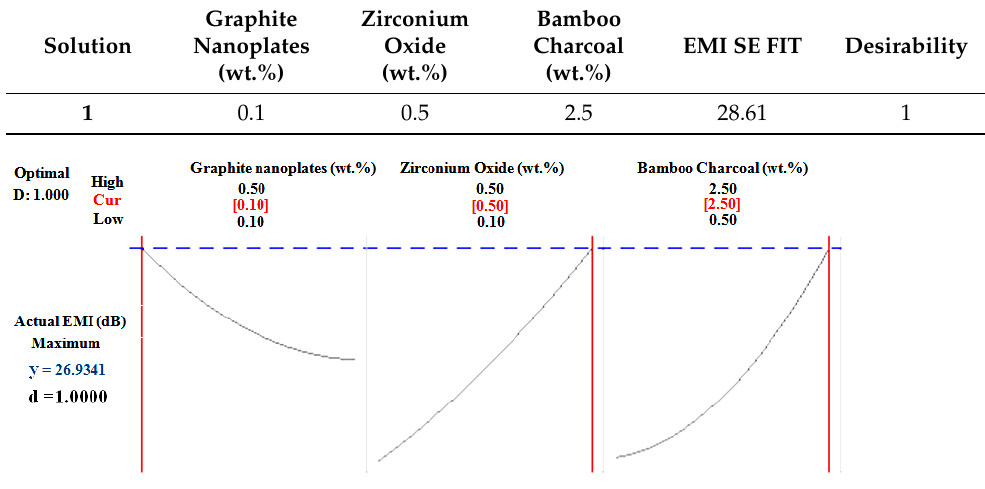
Figure 8. Optimization curvature of factor for different nanoparticles influencing EMI value.